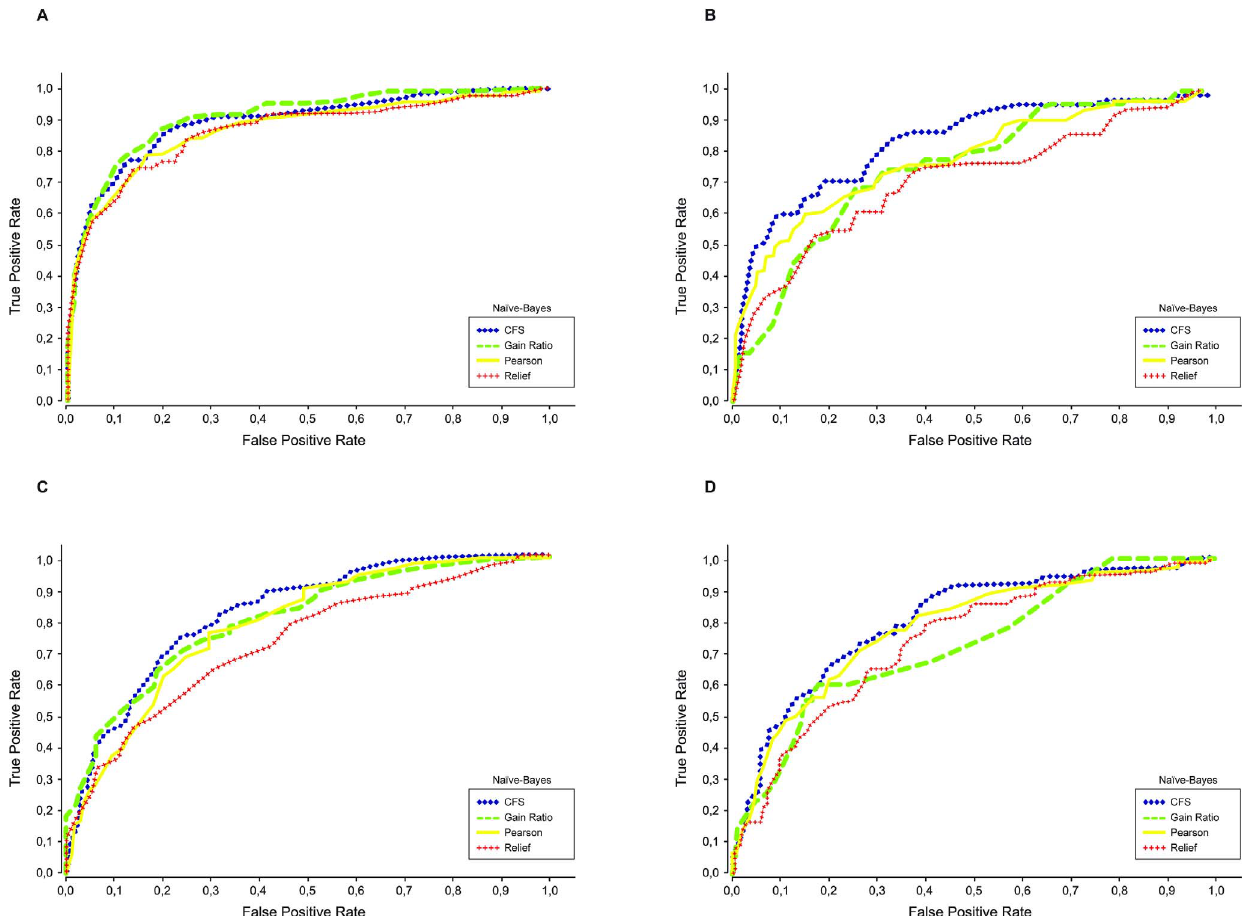
Figure 1. Classifier ROC curves for the Spanish datasets. The ROC curves illustrate the performance for classifying tweets as related to (positive) or not related to (negative) a given health state. Results shown are for a Naı¨ve Bayes classifier trained with the subsets of features generated by four different feature selection algorithms. A) Depression, B) Pregnancy, C) Flu and D) Eating Disorders.